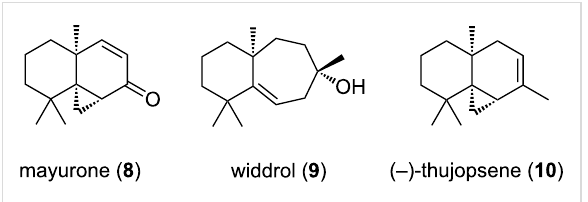
Figure 1: Selected natural products from Thujopsis dolabrata .